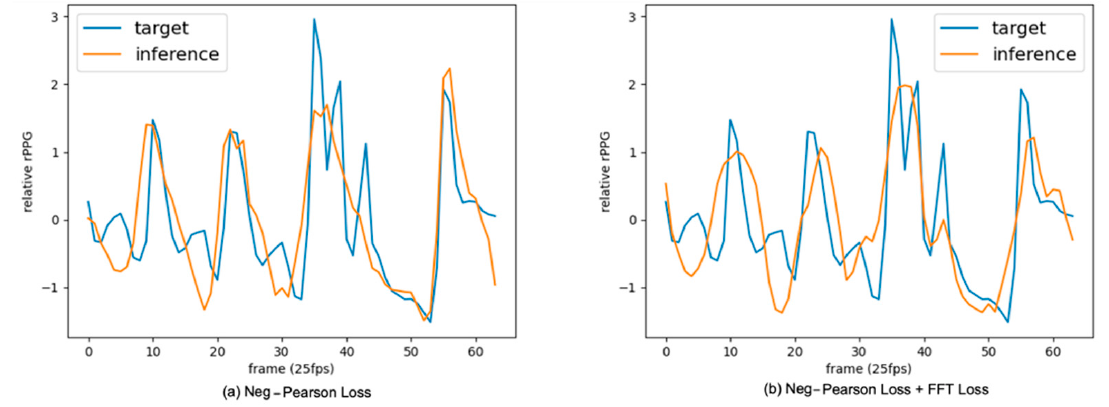
Figure 7. APNET’s inference results. ( a ) Neg-Pearson Loss, ( b ) neg-Pearson Loss + FFT